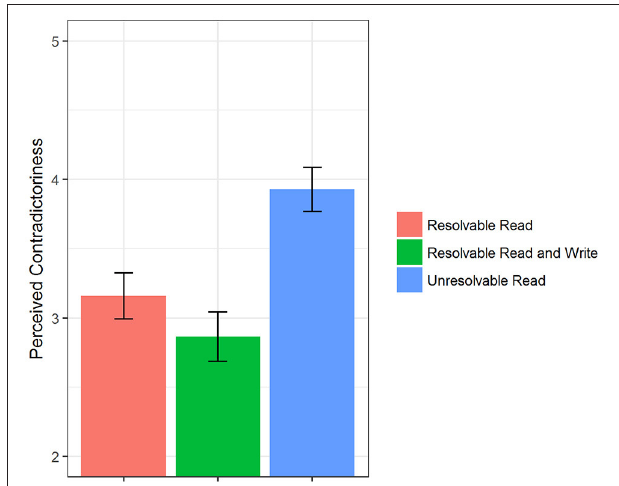
FIGURE 2 | Manipulation Check. Descriptive differences (means and standard errors) in perceived contradictoriness between groups that received controversial information on gender